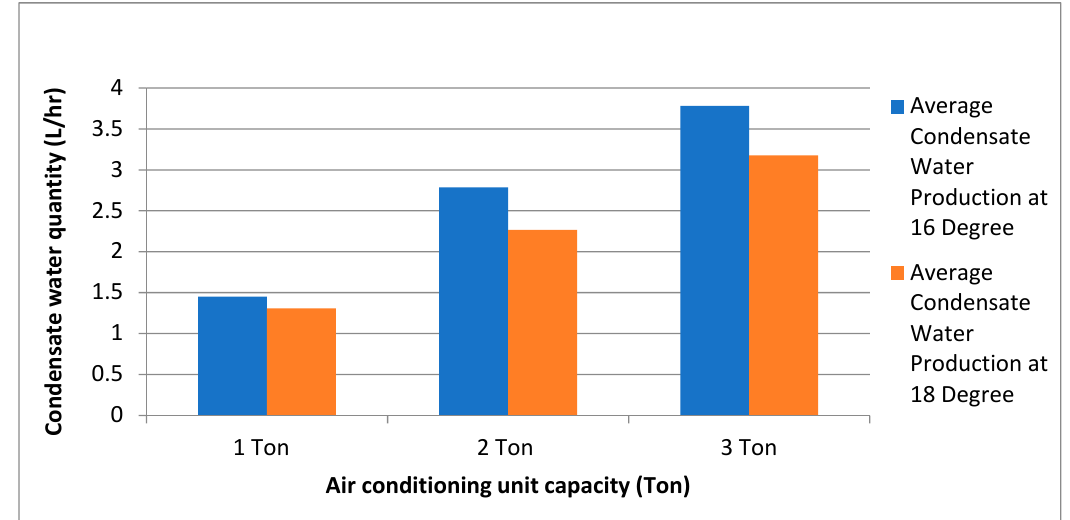
Figure 4. Quantities of condensate water at both 16 °C and 18 °C operating temperatures in Ramallah Figure4. Quantitiesofcondensatewateratboth16 ◦ Cand18 ◦ city.